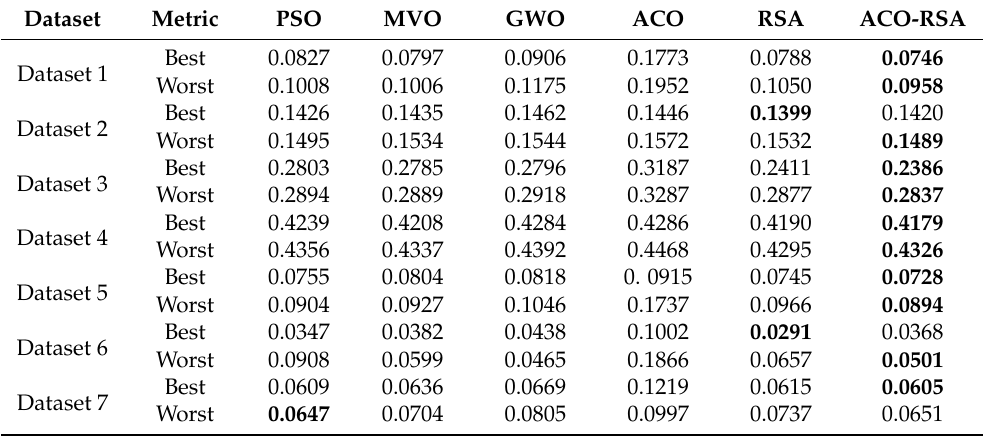
Table 4. The best and worst fitness values of the ACO-RSA and the other MAs.